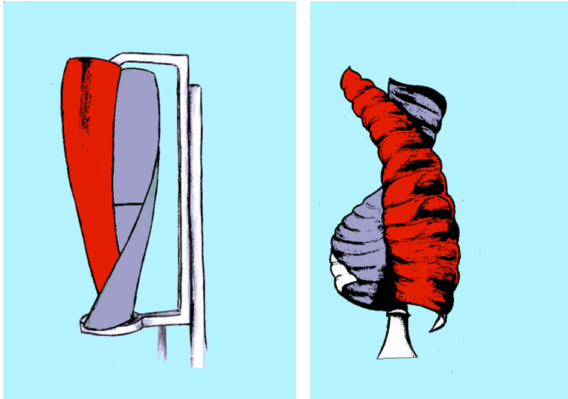
Figure 3. Helical Savonius rotors.